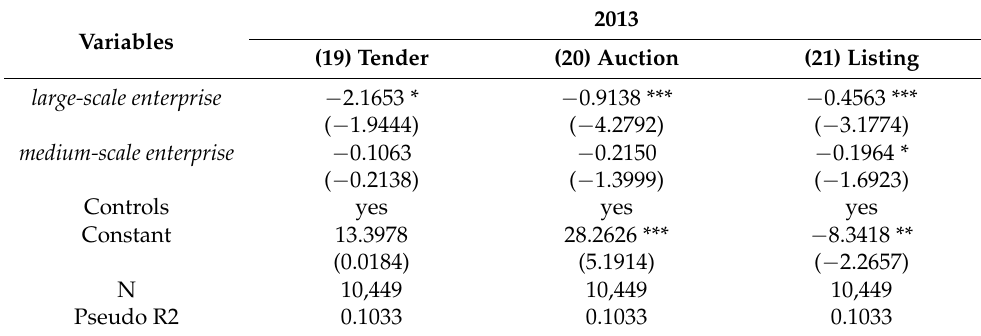
Table A7. Results of mlogit model considering scale of enterprises